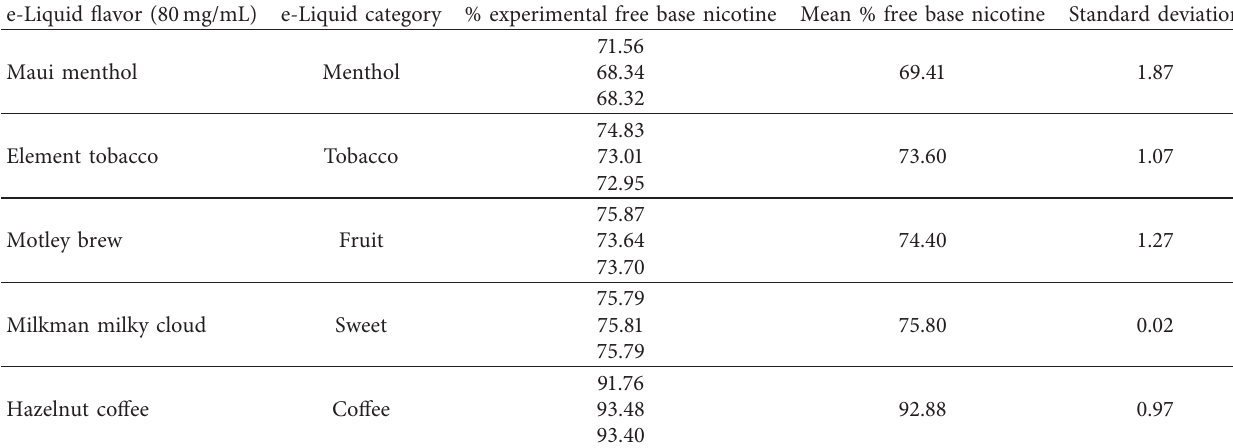
Table 5: Determination of free base nicotine in e-liquids by 1 H NMR spectroscopy (e-liquids without dilution).